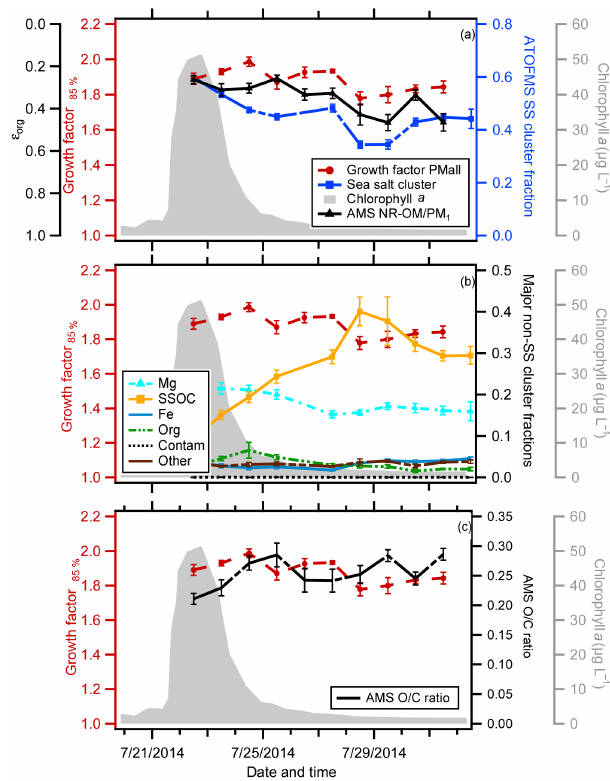
Figure 5. Same as Fig. 3 above but for the outdoor